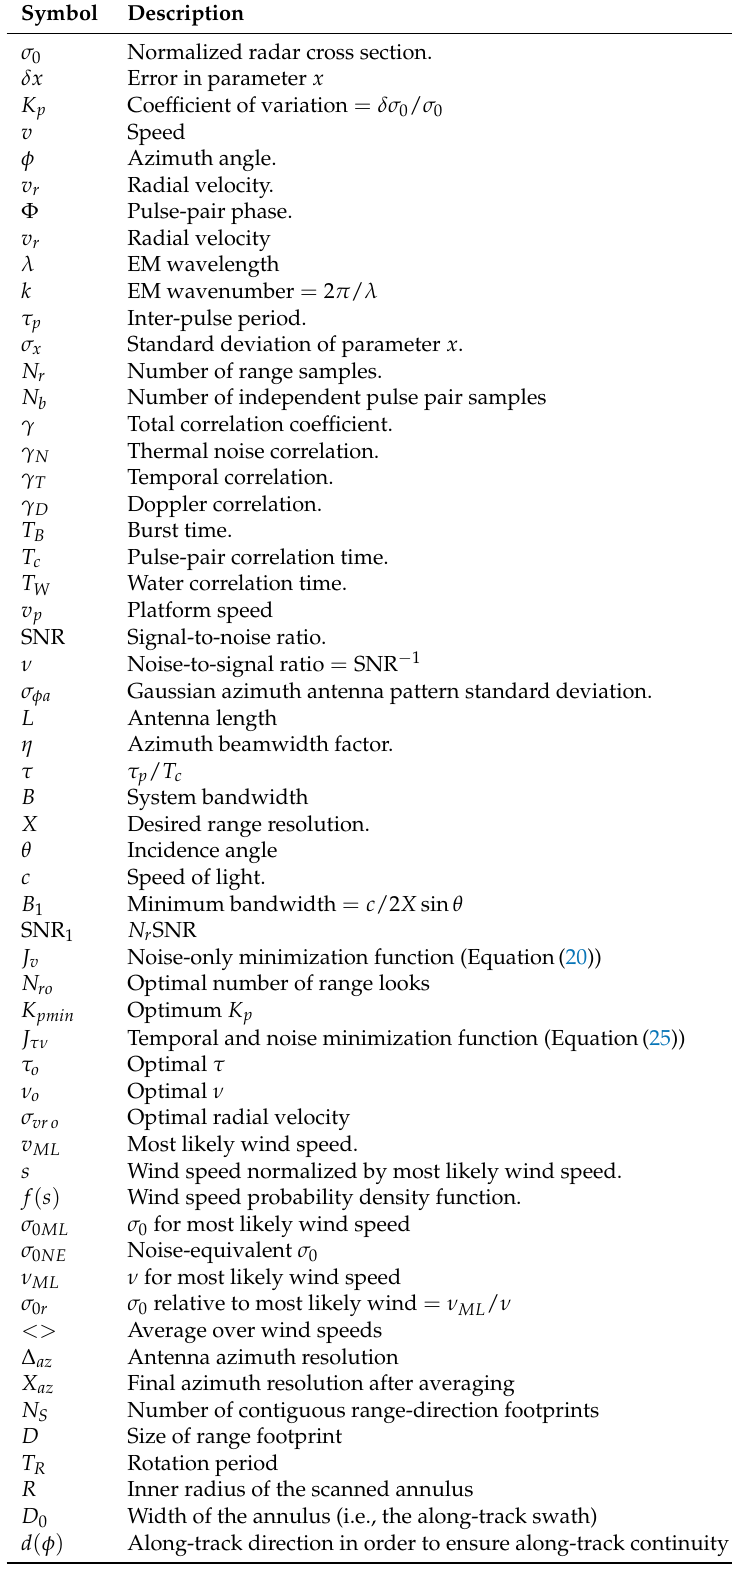
Table A1. Symbols table order as introduced in